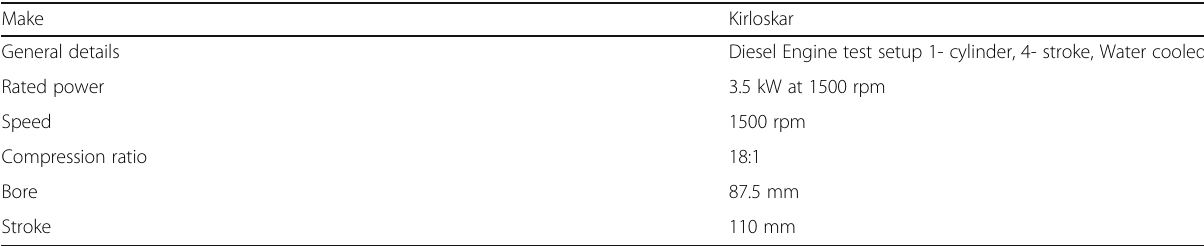
Table 3 Specification of the engine Make Kirloskar General